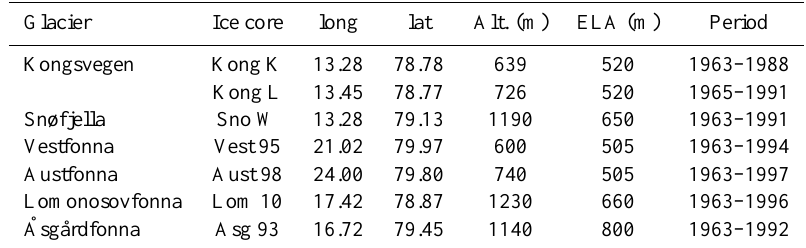
Fig. 6. Winter anomalies of sea ice concentration (%), turbulent heat flux (Wm − 2 ), surface air temperature ( ◦ C) and total precipitation (%) of the A1B, A2 and HYB from the 20C3M simulation. Apart from sea ice, anomalies are significant at the 95% level using a student’s t -test. Table 1. Ice core name, location, altitude, equilibrium line altitude and the period the ice core covers for the ice core sites used in this study (from Pinglot et al.,